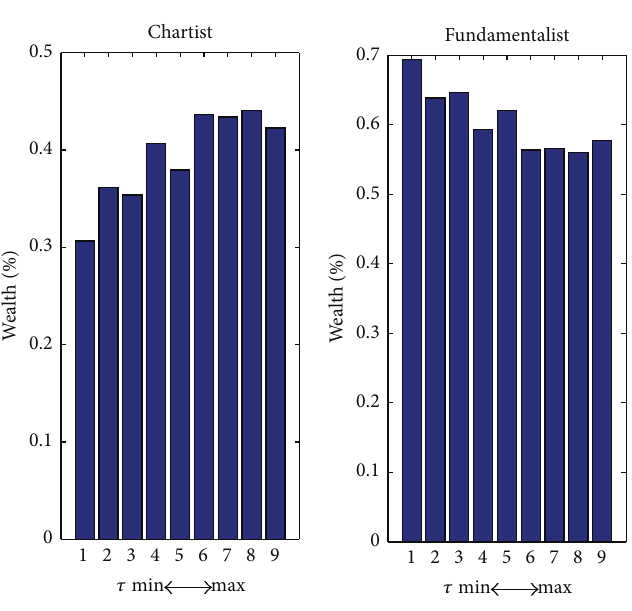
Figure 9: Wealth Shares (𝑑 𝑓 ∈ (0.7, 0.8))